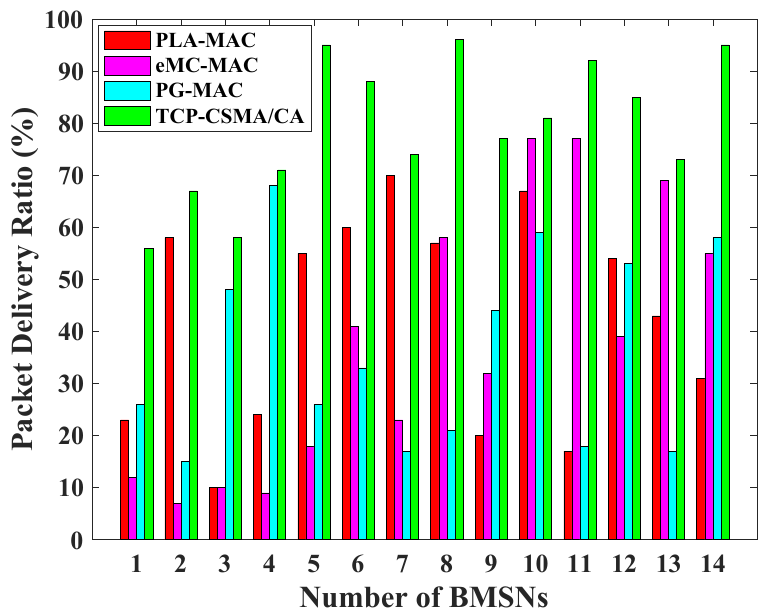
Figure 4. Packet delivery ratio versus number of BMSNs.